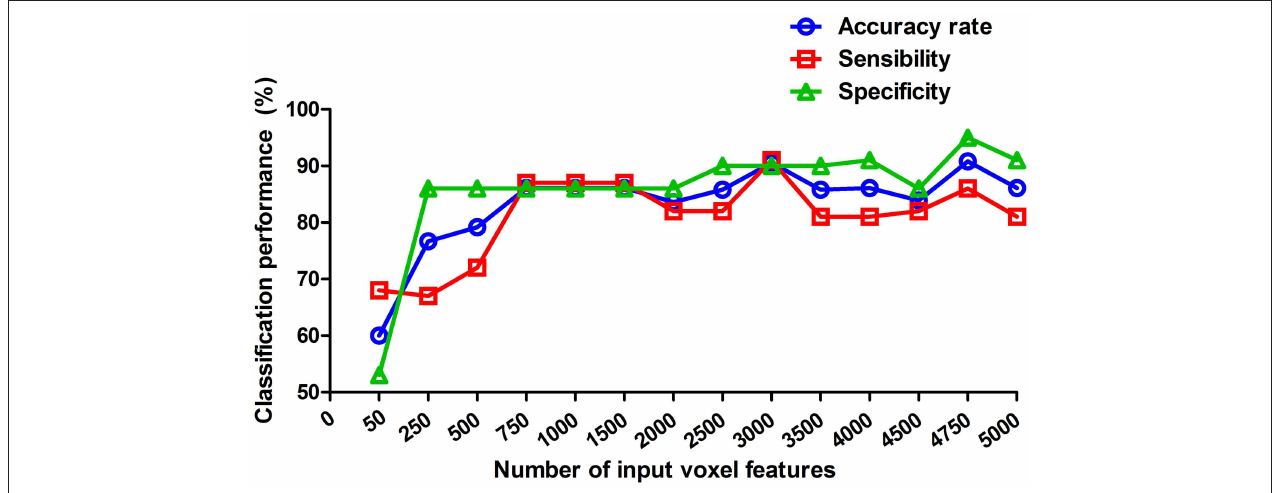
FIGURE 4 | Classification performance at each of reduced data sets. These values reported are of the weighted average of the 5 cross-validation. The reduced data sets were selected by the relief feature selection algorithm. Here, we reported fourteen reduced data sets-50, 250, 500, 750, 1,000, 1,500, 2,000, 2,500, 3,000, 3,500, 4,000, 4,500, 4,750, and 5,000